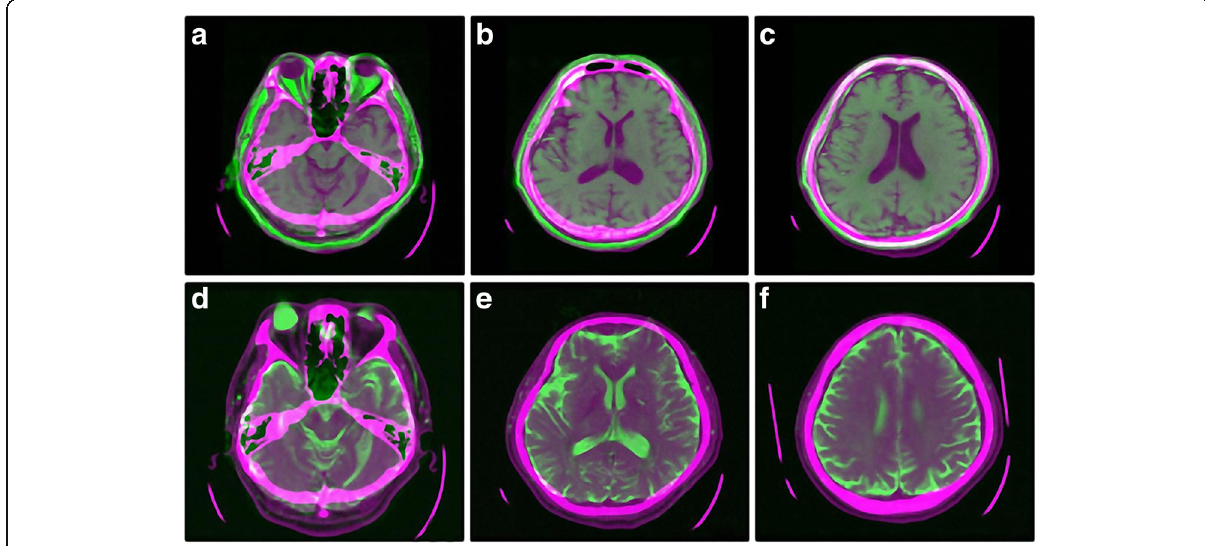
Fig. 19 The pseudo-color fusion result of patient